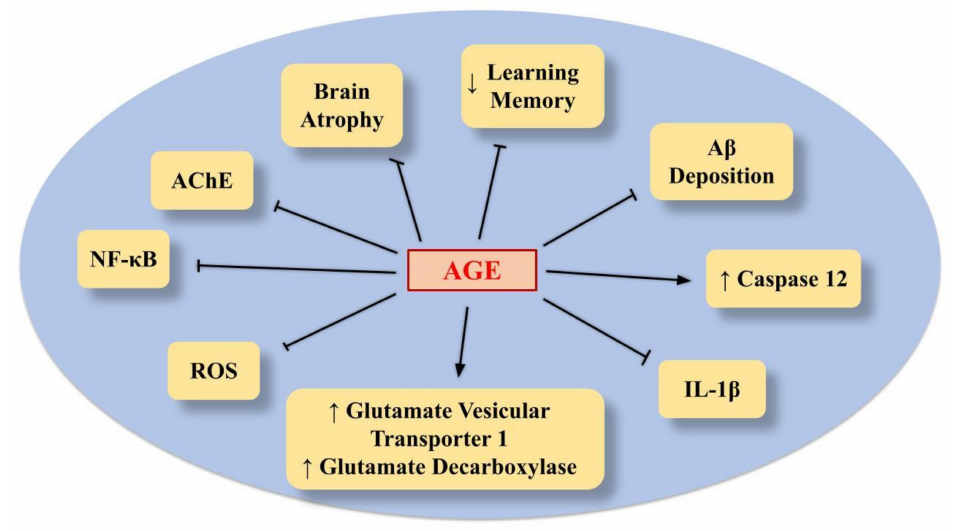
Figure 5. The main events induced by AGE to provide protection in